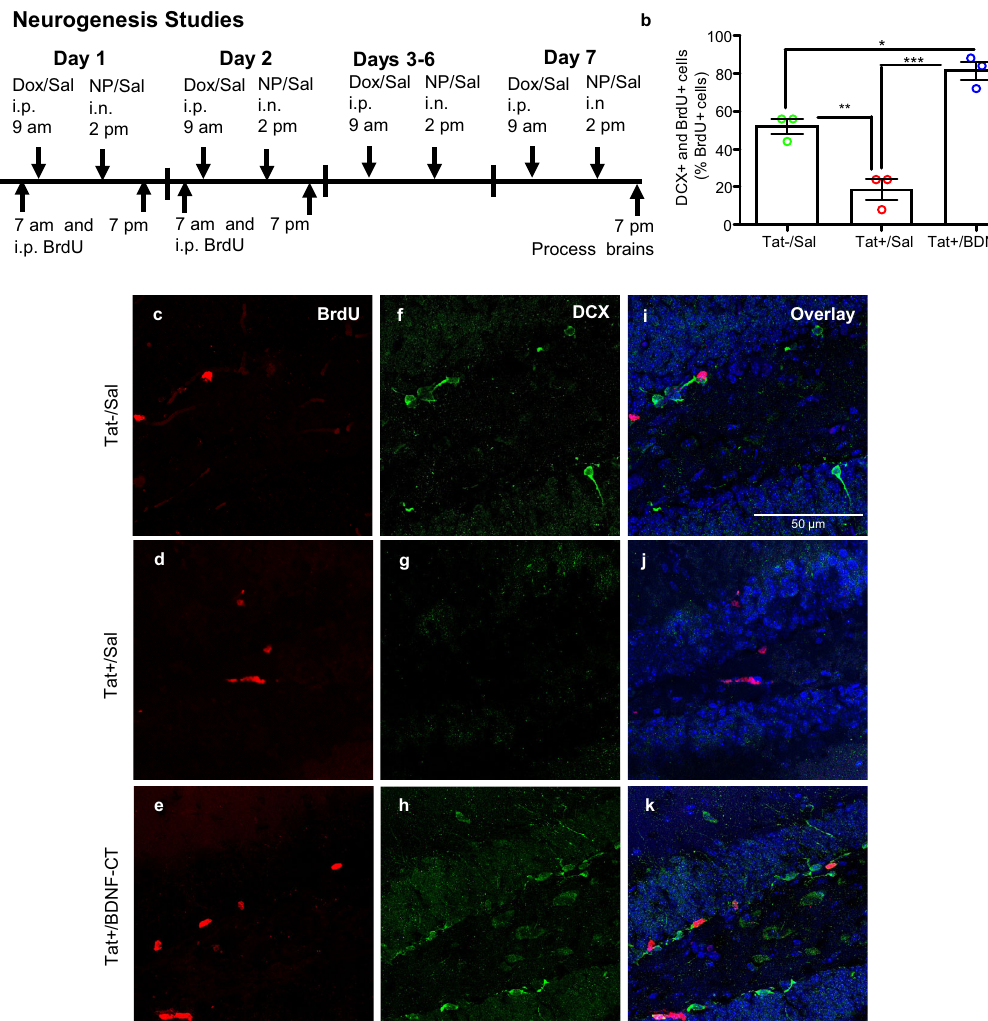
Fig. 5 BDNF-CT rescues neurogenesis from Tat-induced toxicity in the hippocampus. Tat + mice received i.p. Dox and i.n. saline or BDNF-CT nanoparticles (0.3 mg/kg of BDNF and 2.4 mg/kg of CT) daily for 7 days. Tat − controls received i.p. and i.n. saline. All mice received BrdU (50 mg/kg, i.p. every 12 h) on days 1 and 2 and were sacri fi ced on the 7th day ( a ). Hippocampal sections containing the granule cell layer were evaluated and double labeled cells (BrdU + and DCX + ) are expressed as the percentage of BrdU + cells ( b ). The mean percentage was higher in BDNF-CT-treated Tat + mice vs. matched controls (Tat + and Tat − ) that received saline, and was lower in Tat + vs. Tat − mice. BrdU + cells (red, c – e ), DCX + cells (green, f – h ) and double labeled cells (BrdU + and DCX + ) ( i – k ) are shown. Nuclei (blue) were labeled with DAPI. Data are represented as the mean percentage. Error bars represent S.E.M. ( n = 3 per group; * P < 0.05, ** P < 0.01, and *** P < 0.001). Scale bars are 50 µ